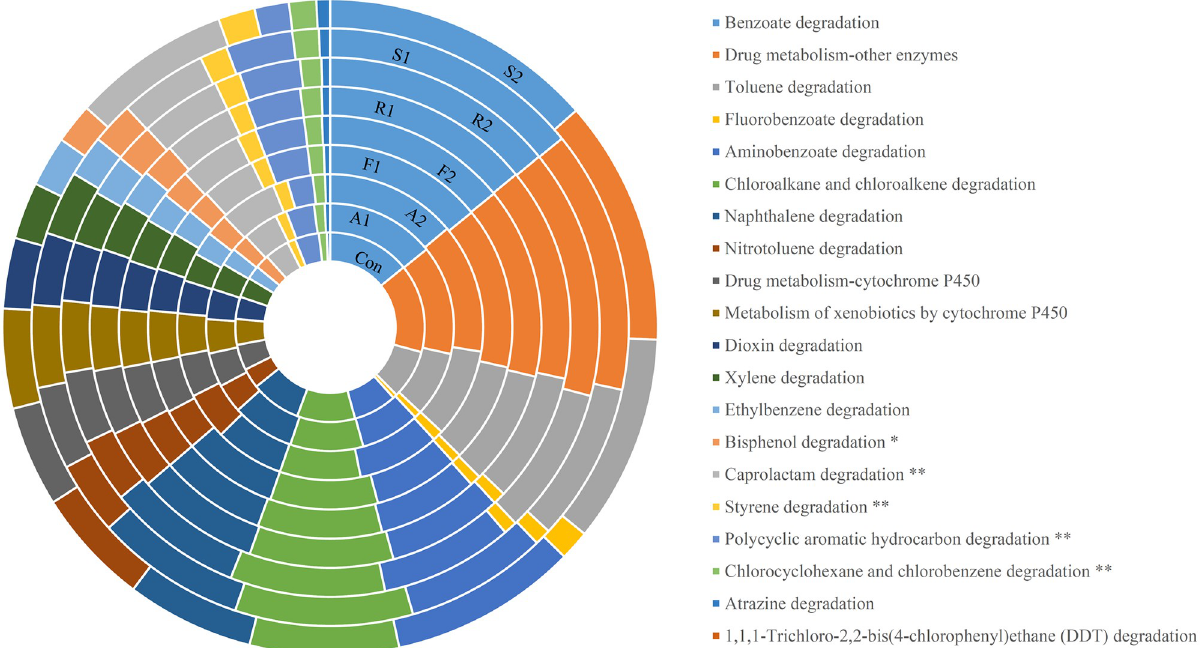
Fig 5. Functional analysis of the proteins involved in biosynthesis of xenobiotics biodegradation and metabolism. �� means significantly different between F2 and some other samples except for A2 ( p < 0.05; FDR < 0.05); � means significantly different between F2 and some other samples except for A2 ( p < 0.05; 0.05 < FDR <